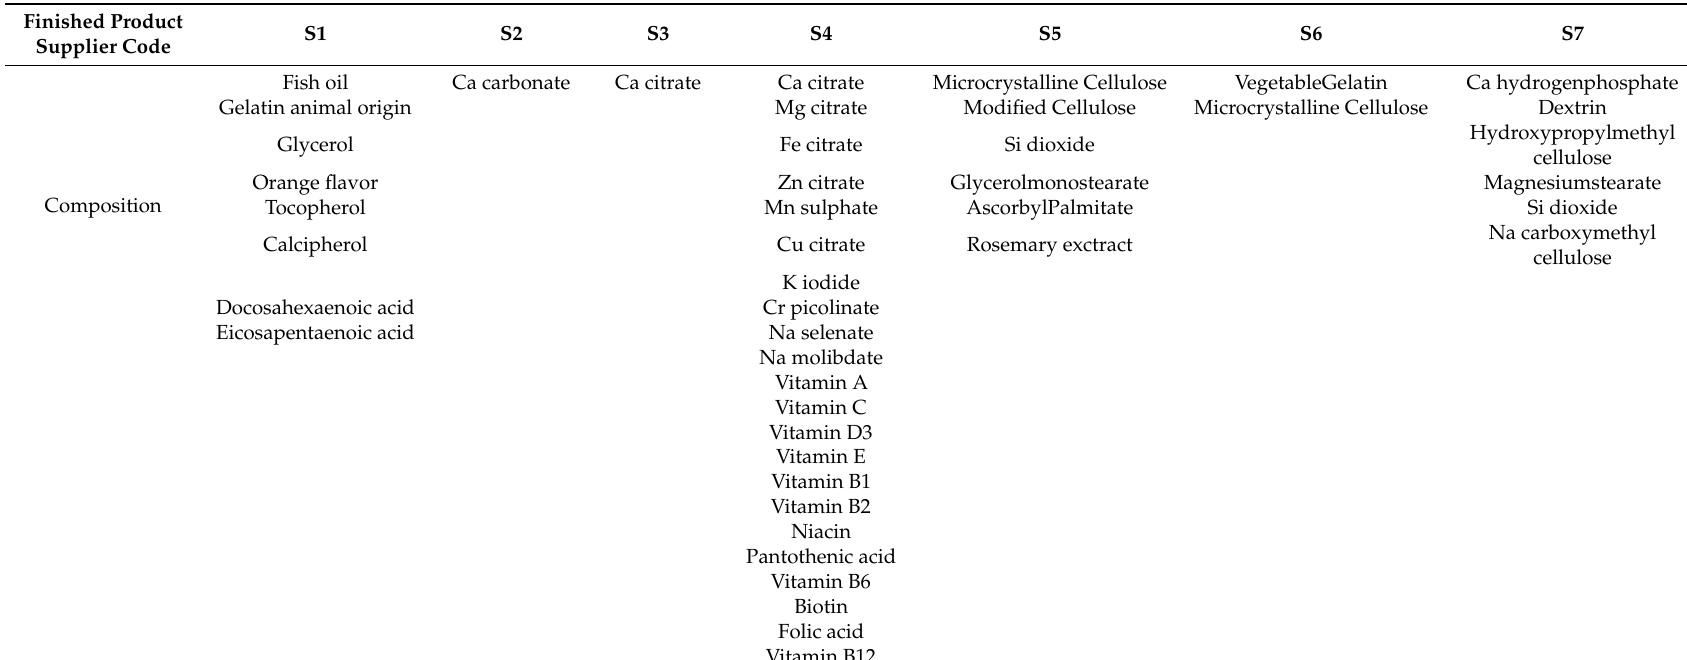
Table 3. Product composition (from product